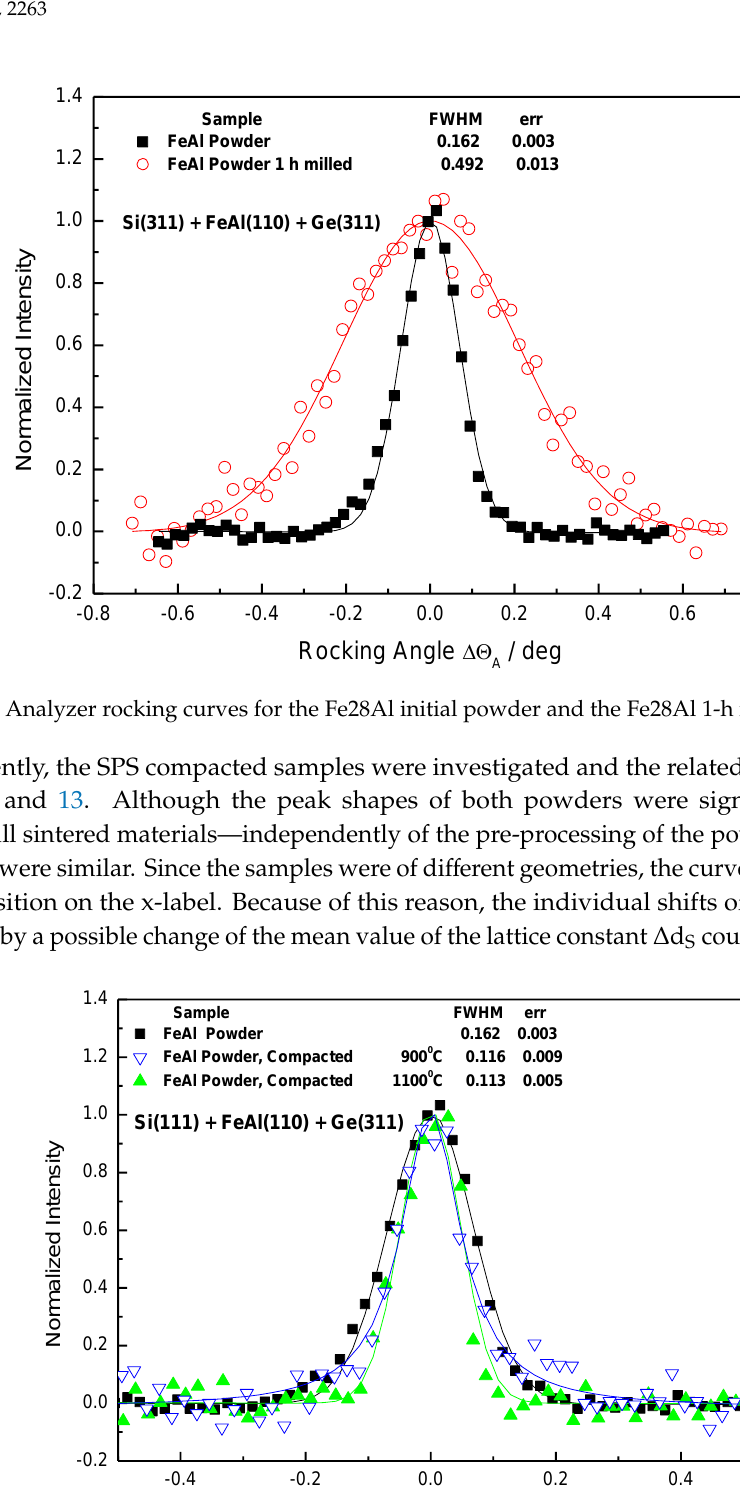
Figure 12. Analyzer rocking curves for the SPS compacted Fe28Al from the initial powder sintered at 900 °C, 1000 °C, and 1100 °C.